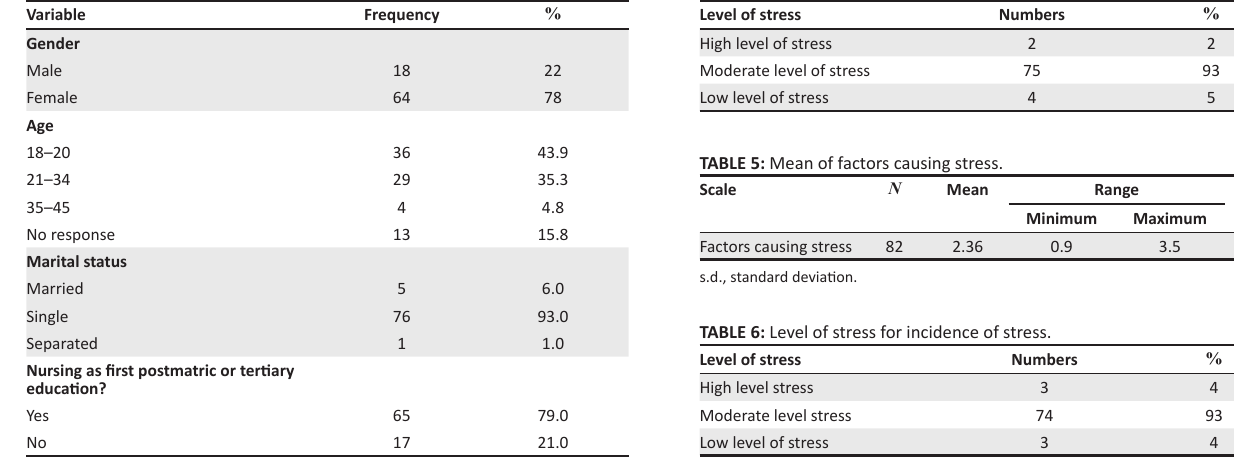
TABLE 1: Respondents’ demographic characteristics.